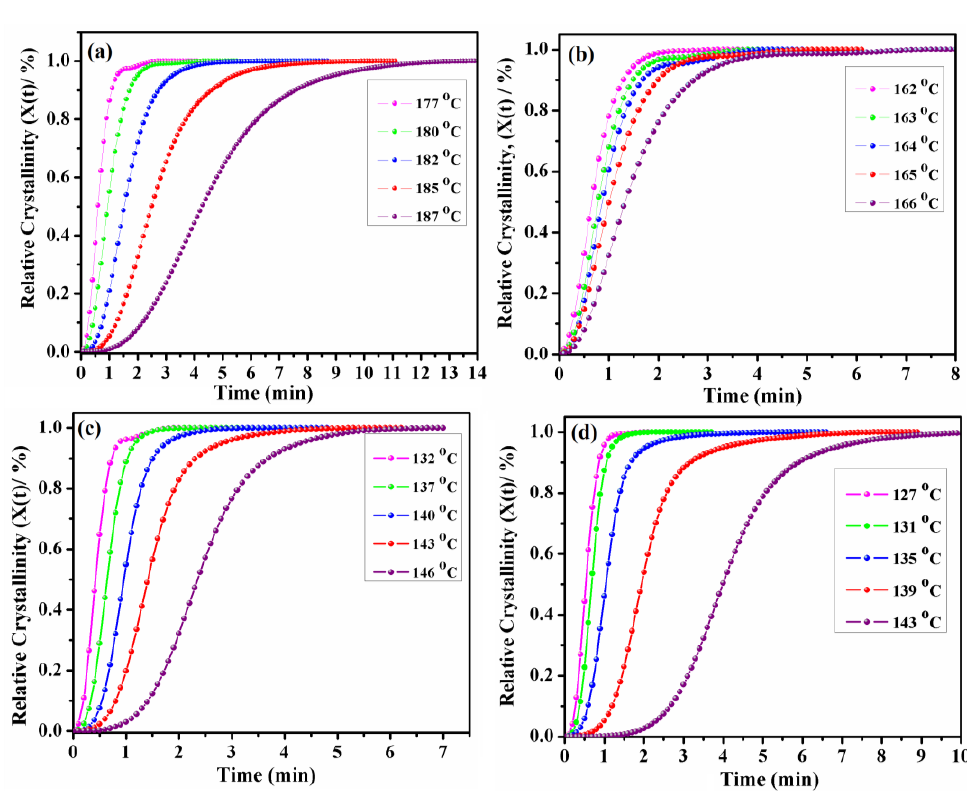
Figure 7. Plots of the relative crystallinity X ( t ) versus crystallization time at various isothermal crystallization temperatures ( T iso ) for ( a ) virgin PA6, ( b ) PA6-BABA/SA 30 , ( c ) PA6-BABA/SA 50 , and ( d ) PA6-BABA/SA 70 .